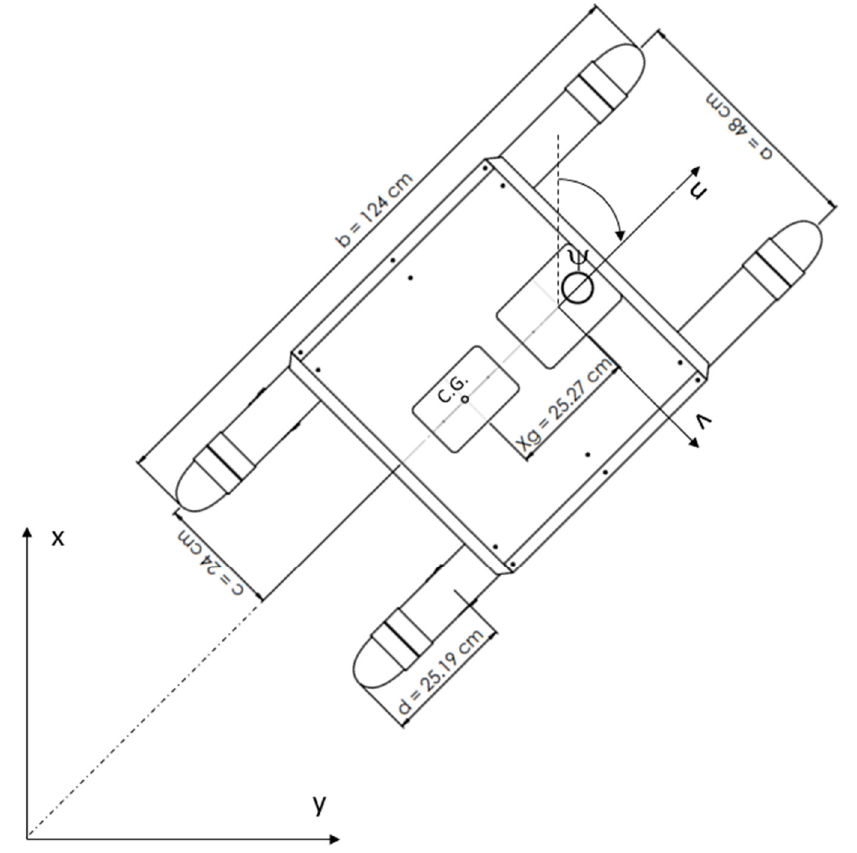
Figure 1. Free Body Diagram (a = nose to nose distance, b = USV length, c = thruster to center of gravity horizontal distance, d = thruster to nose tip distance, x g = centre of gravity distance to USV frame of